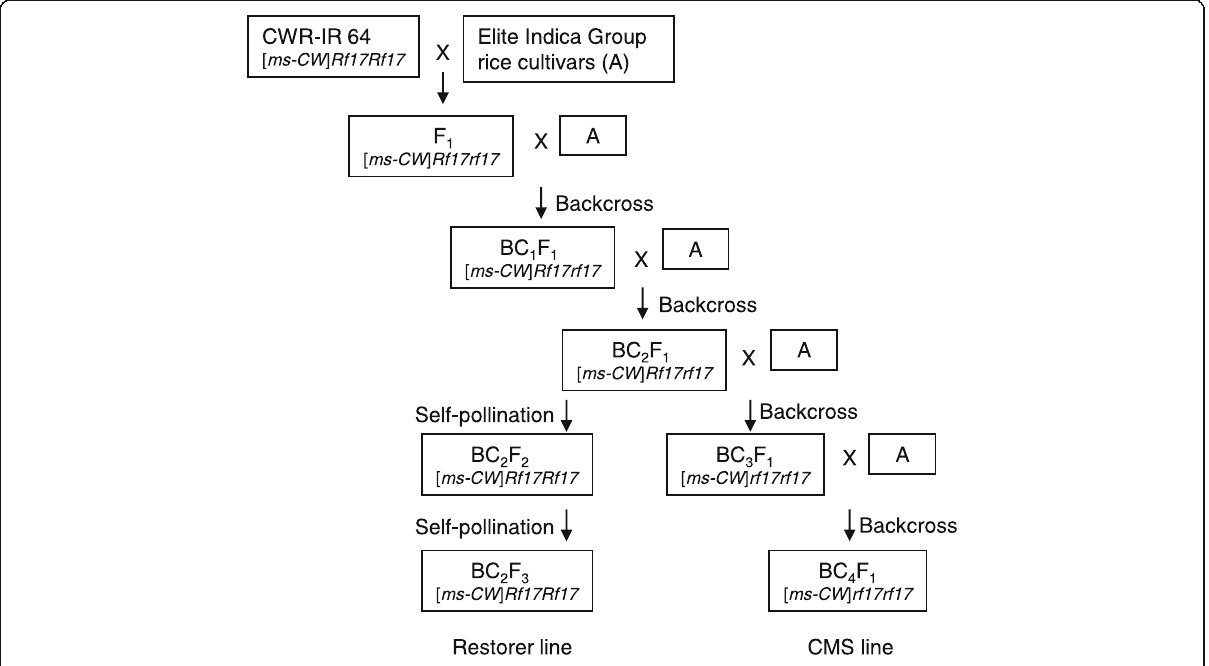
Fig. 1 Flowchart of developing new CMS lines and restorer lines. [ ms-CW ] indicates the